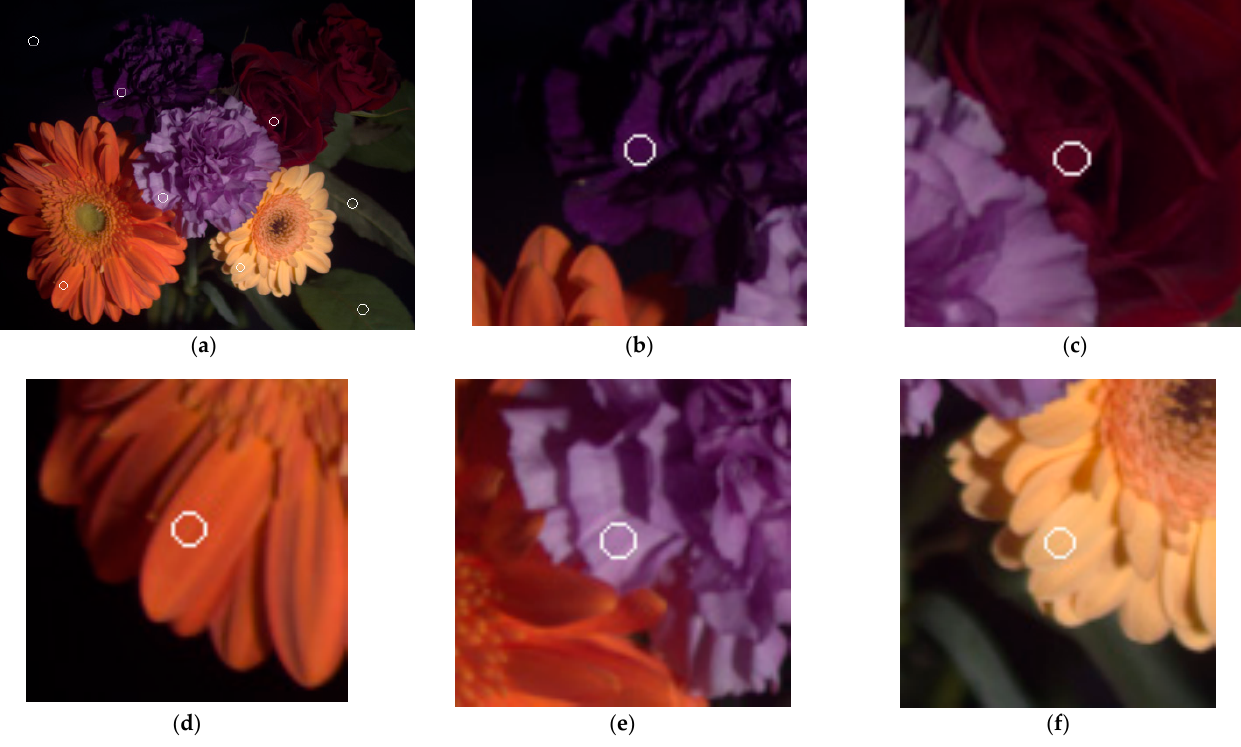
Figure 20. ( a ) Original image of Figure 15d. ( b – f ) showing enlarged images on the deep purple, red, orange, purple and yellow flowers in ( a ), respectively. The center of the white circle was an example pixel showing the recovered spectral reflectance, except for the white circle in the upper left corner.